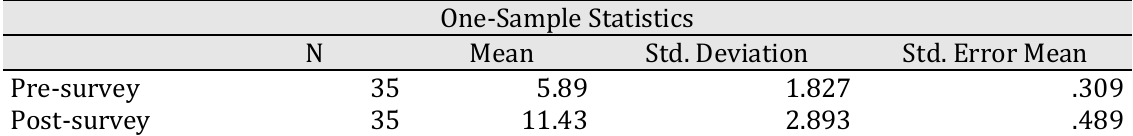
Table 21. Students’ Result of t -test from Pre-survey and Post-survey result